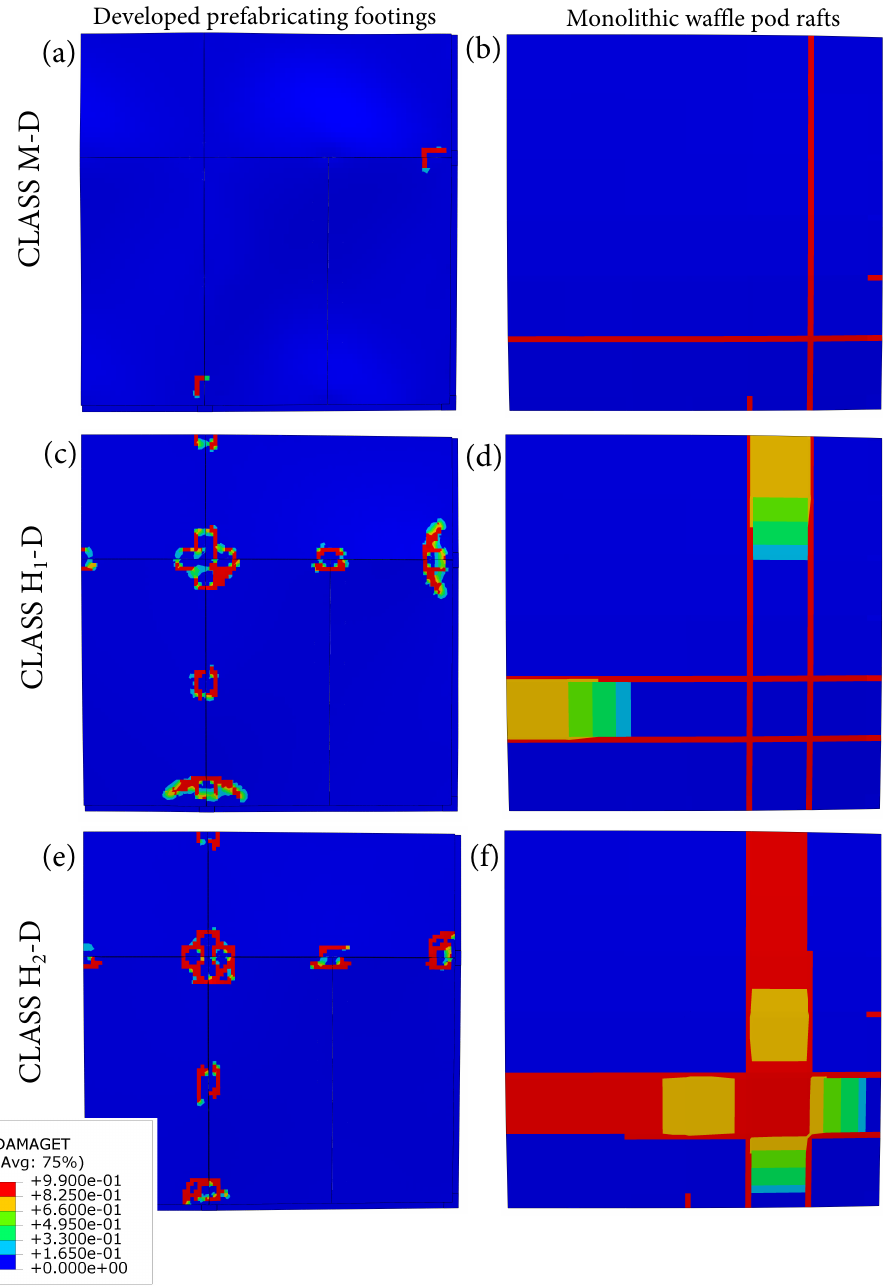
Figure A5. Comparison of footing damage due to shrinking soil between the developed prefabricated footing systems and waffle rafts for ( a , b ) Class M-D soil, ( c , d ) Class H 1 -D soil, and ( e , f ) Class H 2 -D soil. A value of DAMAGET ( d t ) greater than zero reflects concrete cracking, classified as: DAMAGET ( d t ) < 0.25 = hairline cracks, 0.25 ≤ DAMAGET ( d t ) < 0.85 = fine but noticeable cracks, 0.85 ≤ DAMAGET ( d t ) < 0.99 = distinct cracks, and DAMAGET ( d t ) ≥ 0.99 = wide cracks or gaps